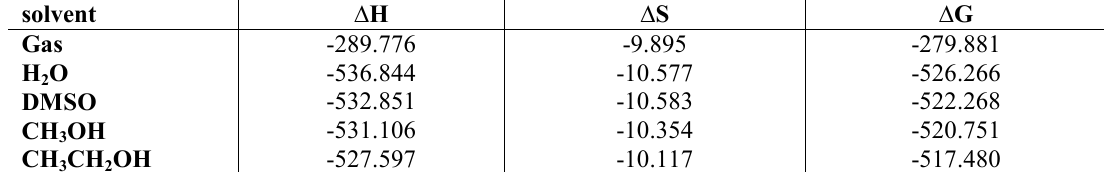
Table 4. ∆H, ∆S, and ∆G in kcal/mol for V isomer at the BLYP/6-311++G** level in different solvents at 298 k.